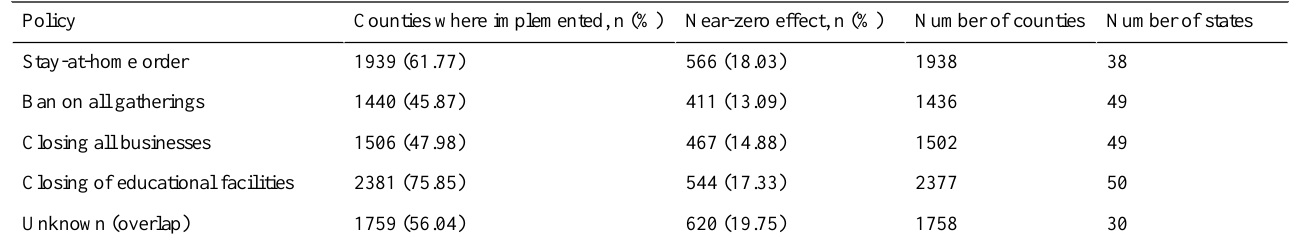
Table 2. Percentages of policy effects across counties with estimated near-zero effect and percentage implemented (N=3139).